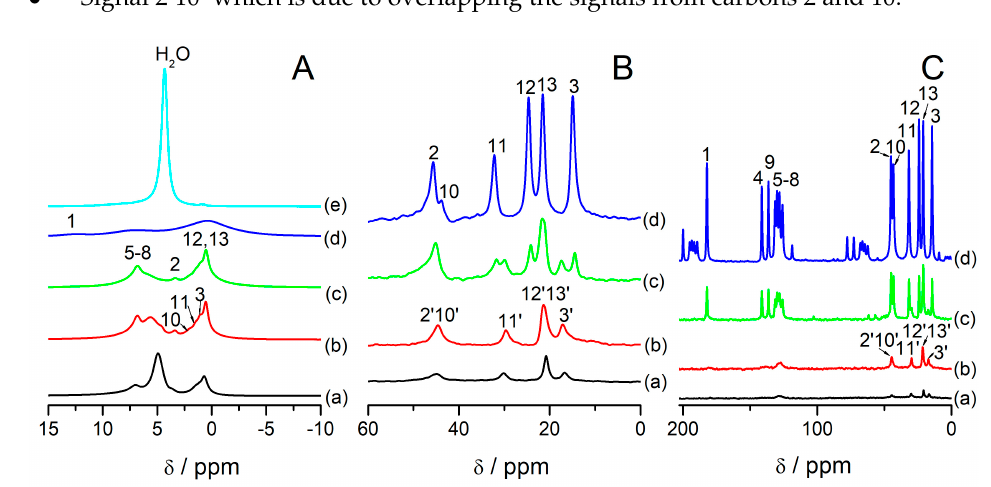
Figure 3. 1 H ( A ), 13 C HPDEC ( B ), and 13 C CP ( C ) MAS NMR spectra of the samples: FAU31–12IBU ( a ), FAU31–24IBU ( b ), FAU31–38IBU ( c ), ibuprofen ( d ), and FAU31 ( e ) under ambient conditions (room temperature and atmospheric humidity). The signals were assigned according to the convention presented in Figure S3 (Supplementary Information). Apostrophes indicate signals from ibuprofen molecules located in mesopores (more details in text).